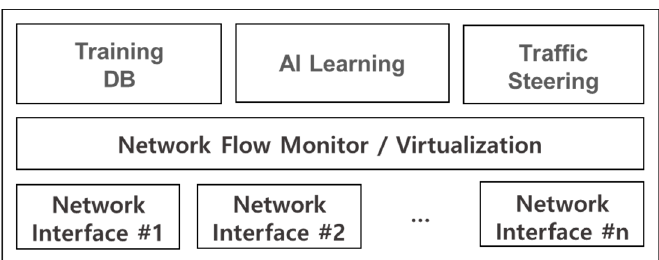
Figure 6. Traffic control architecture using machine learning [33].